Question: What kind of plot is shown here?
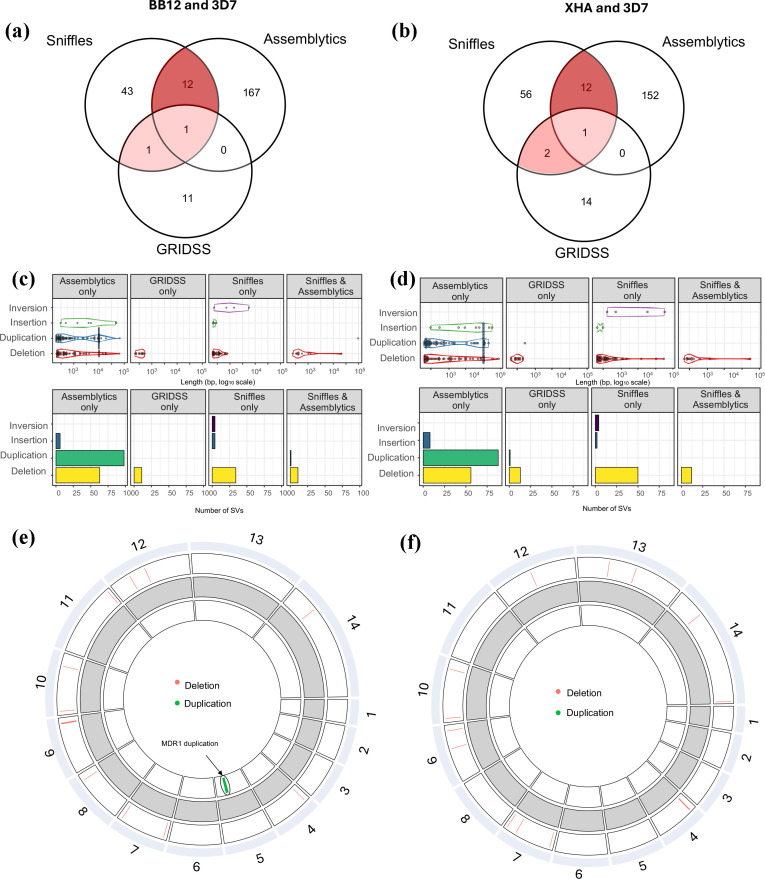
Answer: box